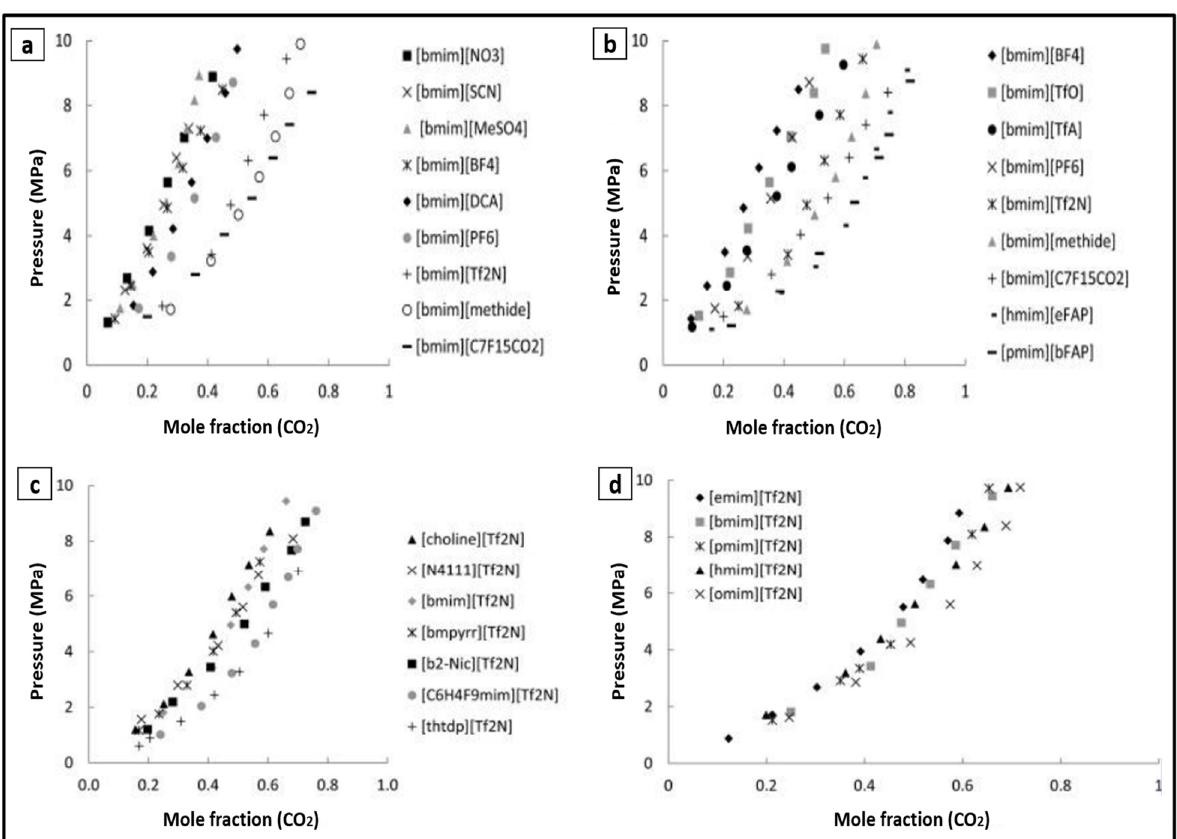
Figure 3. ( a ) Anion effect on the solubility of CO 2 . CO 2 has higher solubility in fluorinated anions in comparison with non-fluorinated anions. ( b ) Anion fluorination effect on solubility. The solubility of CO 2 is enhanced as the anion no. of fluor groups rises. ( c ) The effect of cations on CO 2 solubility is minor. ( d ) Alkyl chain length on the solubility of CO 2 . As the length of the alkyl chain increases, the solubility of CO 2 also increases. With permission from Ref. [41]. Copyright 2012, American Chemical Society.